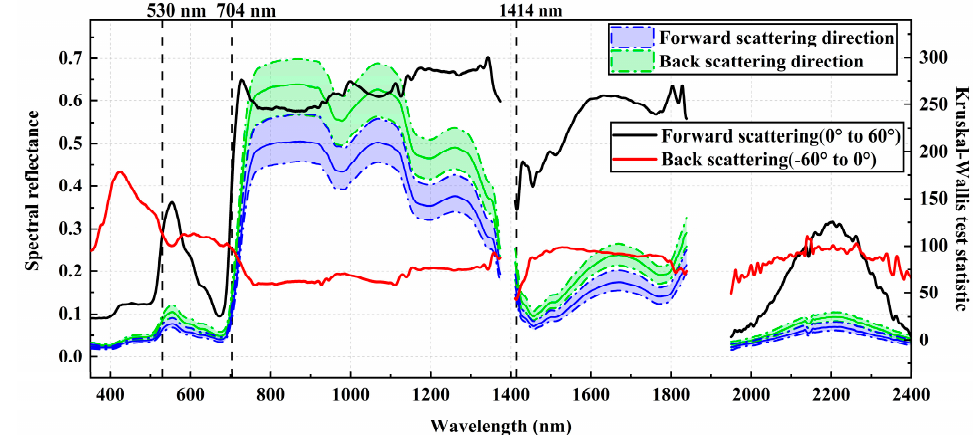
Figure 4. Cotton canopy spectral change characteristics under two-way observation angles (purple and green areas are one-quarter median and three-quarters median spectral reflectance ranges in two scattering directions (n = 2340)). Solid black and red lines are Kruskal–Wallis test statistics between different viewing angles for two scattering directions (n = 1170).